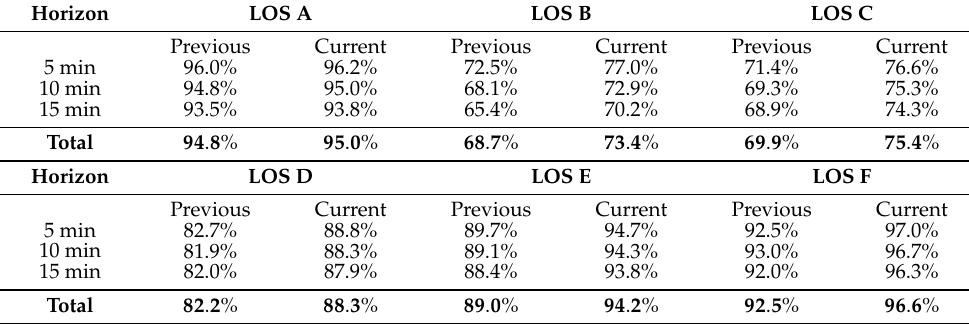
Table 3. Improvements with respect to prior results in each LOS.